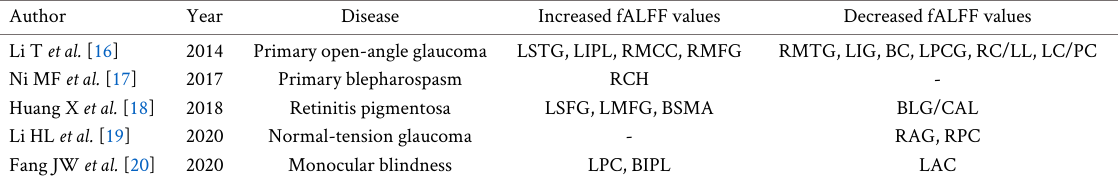
Table 3. fALFF method applied for ophthalmological diseases.